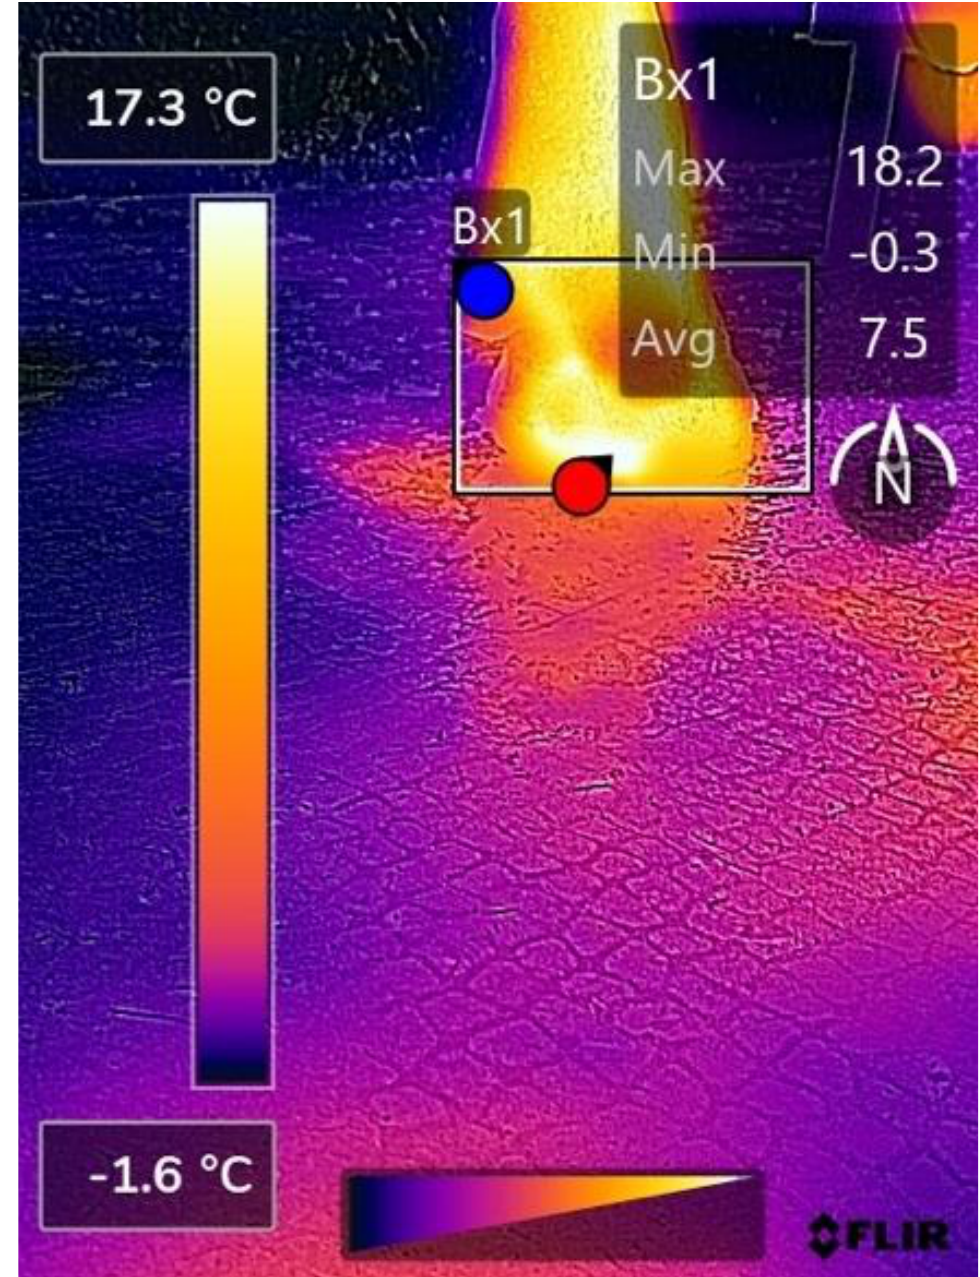
Figure A6. A thermogram, obtained by the CAT s62-Pro Smartphone (LCD), of cattle diagnosed with digital dermatitis on routine foot trimming, displaying a pattern of heat with maximum intensity over the interdigital space, rather than between the heel bulbs.